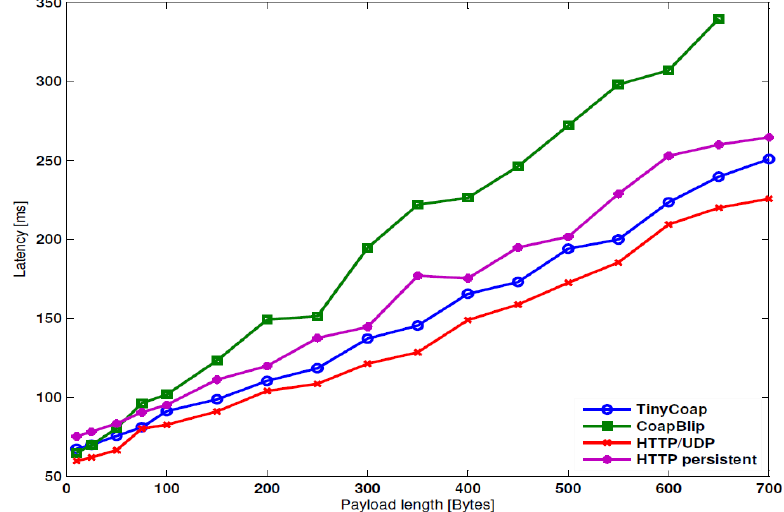
Figure 7. Details of the latency results. The better memory management of TinyCoAP allows the performance of CoapBlip to be